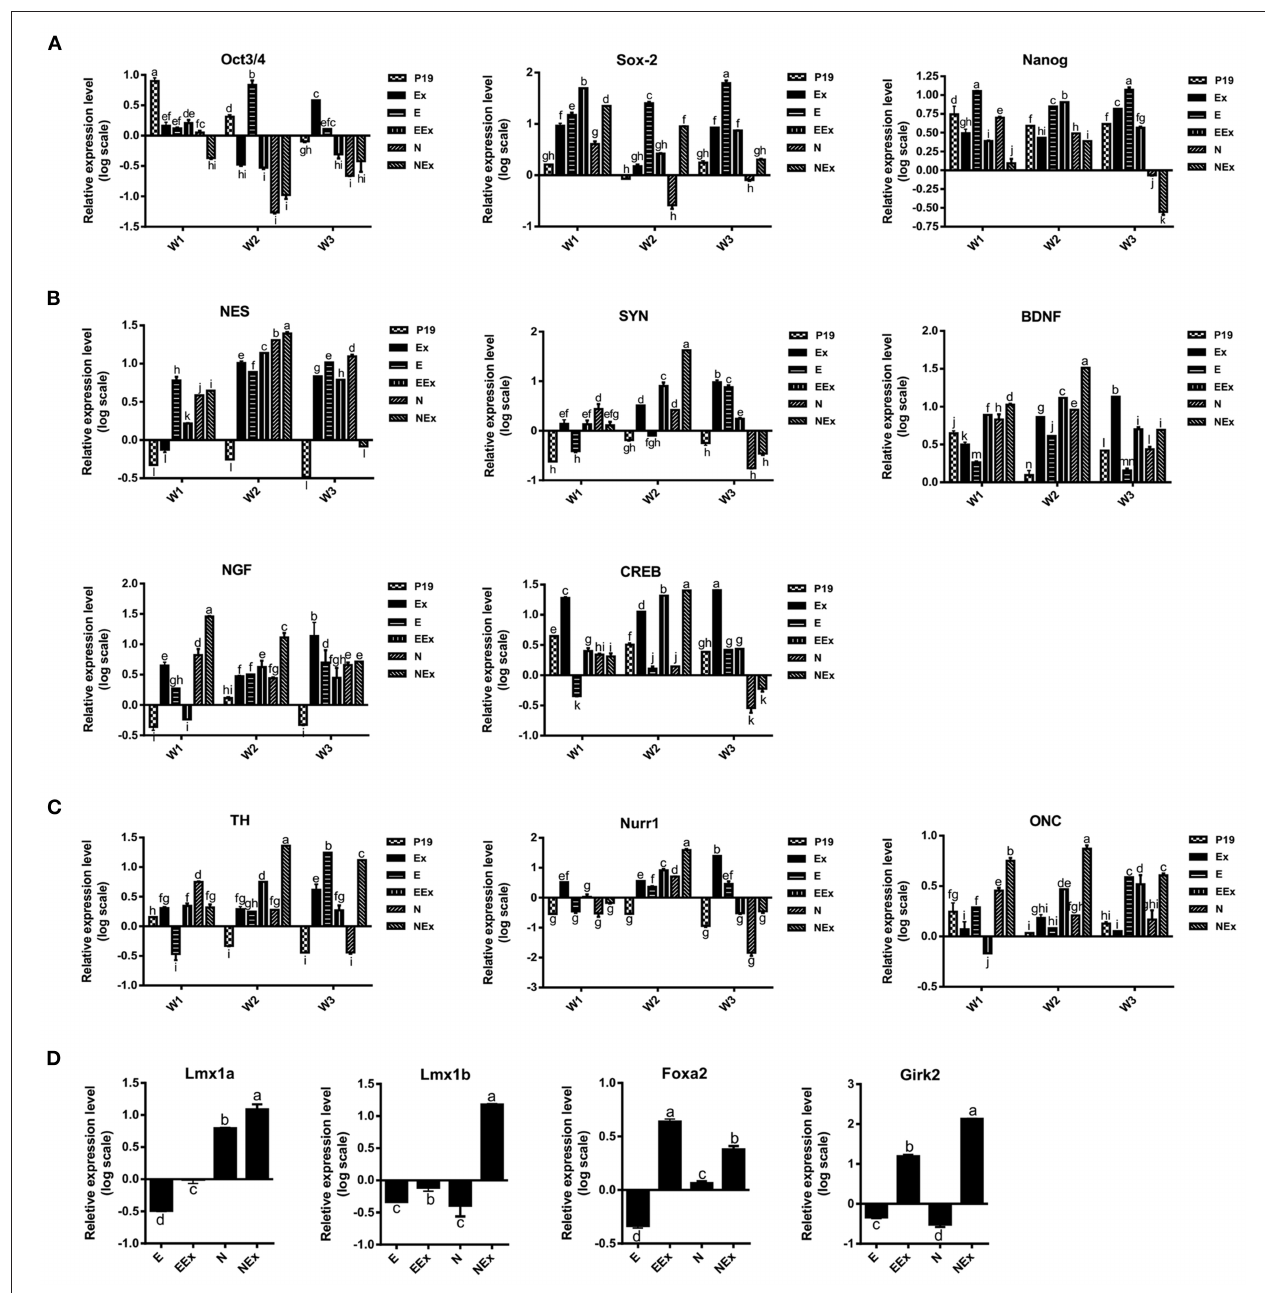
FIGURE 4 | Evaluation of gene expression profile in the experimental groups by quantitative Q-PCR. (A) The expression of stem cell markers tend to decrease in treatment groups. Sox-2 expression was lowest in the N group, and the lowest level of Oct3/4 gene expression was in N, NEx, EEx, and Ex groups during the second week of differentiation. Nanog gene expression was at its lowest level in the NEx group in the third week. (B) The level of neuroepithelial (nestin) and neural-specific genes increased in the second week with their highest expression in the NEx group. (C) TH, Nurr1 and onecut followed nearly the expression pattern of neuronal genes, and their expression increased in the NEx group compared to the other groups. Despite Oct3/4 and Nanog, the expression of Sox-2 significantly enhanced in the NEx group. (D) During the second week of differentiation the expression of other specific markers of dopaminergic neurons including Lmx1a and Lmx1b was significantly increased in the NEx group. Foxa2 gene expression was at its highest level in the EEx group. Furthermore, Girk2; a marker preferentially expressed by neurons of the substantia nigra, showed significant enhancement in the NEx group. The experiments were carried out at least in triplicate. Bars represent standard error and different lowercase letters indicate significant differences by LSD test at P < 0.05, n = 3. For the variables with same letters, the difference is not statistically significant, and for the variables with different letters, the difference is statistically significant. P19, EBs with no treatment ( α -MEM + 5% FBS); Ex, EBs treated by brain extract ( α -MEM + 5% FBS + 100 µ g/ml NRBE); E (empty), EBs transfected with pCMV3-GFPSpark vector; EEx (empty/extract), EBs transfected with pCMV3-GFPSpark vector and treated by extract; N (Nurr), EBs transfected with pCMV3-NR4A2-GFPSpark vector; NEx (Nurr/extract), EBs transfected with pCMV3-NR4A2-GFPSpark vector and treated by extract; W1, W2, W3, week 1, 2, 3, respectively.